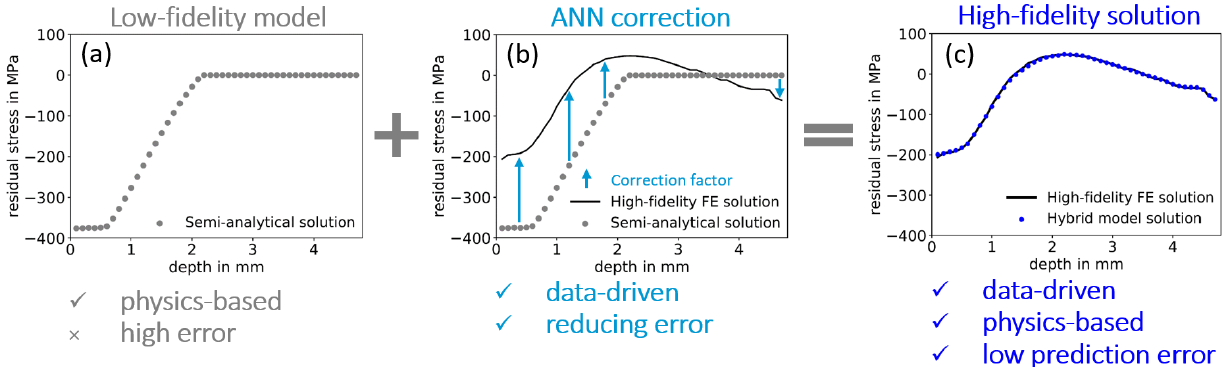
Figure 5. Schematic of hybrid model implementation for prediction of laser shock peening (LSP)-induced residual stresses: ( a ) Residual stresses predicted by the semi-analytical model exhibiting relatively high prediction errors compared to the high fidelity FE solution which is compensated by ( b ) a correction factor “learned” by an artificial neural network (ANN), leading to ( c ) the validated high-fidelity prediction with low errors, i.e., the hybrid model